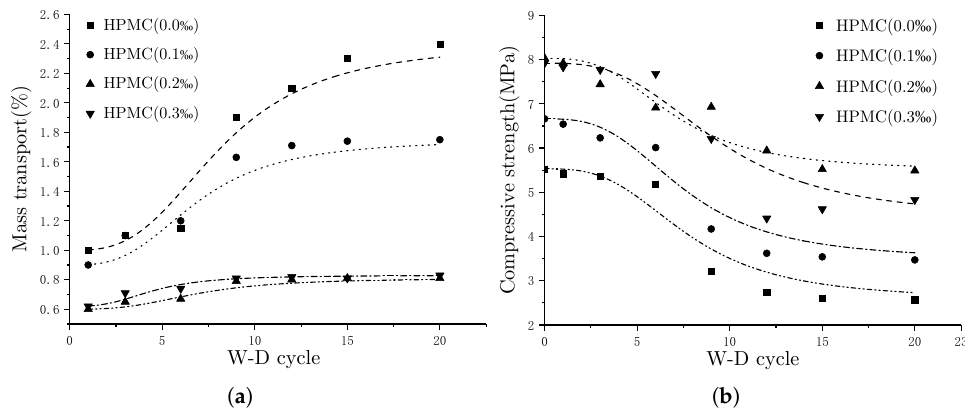
Figure 6. The variations of the mass transport and compressive strength of the porous concrete versus w-d cycles. ( a ) Mass transport versus w-d cycles; ( b ) Compressive strength versus w-d cycles.